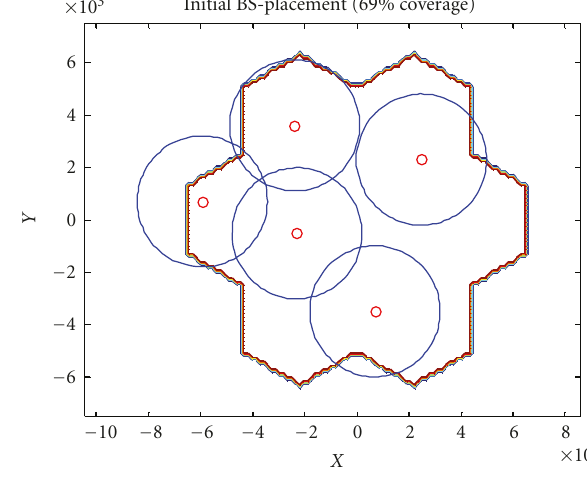
Figure 12: Initial base station location.